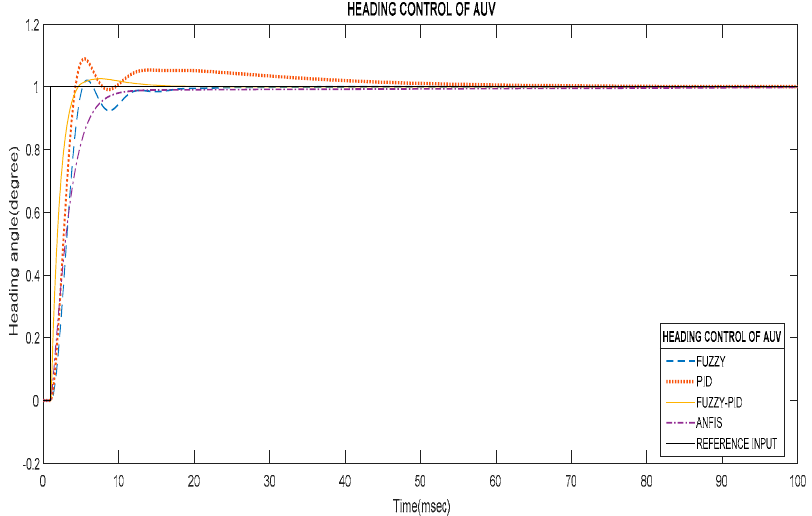
Figure 19. Step response curve of heading plane control by FLC, PID, self - tuning fuzzy - PID, and ANFIS control techniques.